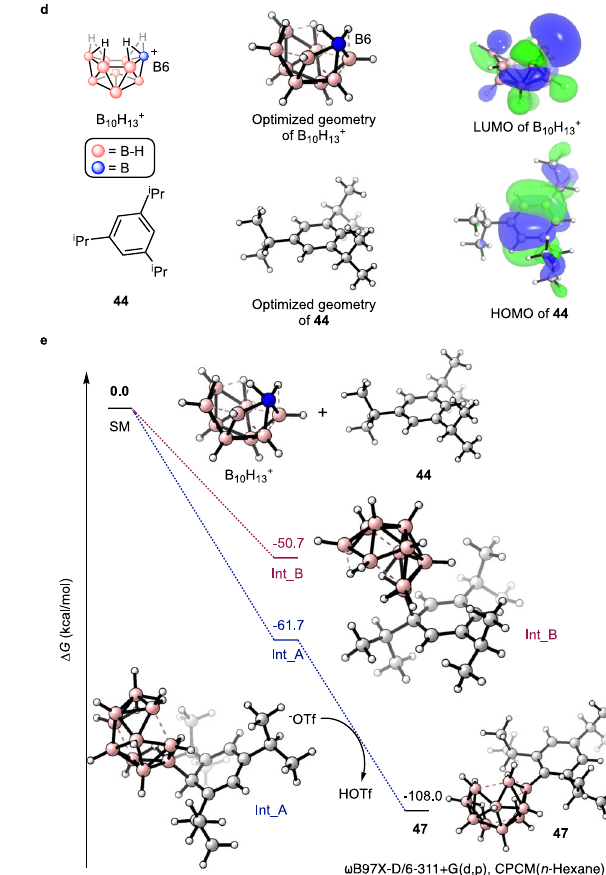
e DFT-calculated reaction pro fi le for the formation of 47 from B 10 H 13 + and 44 . All DFT calculations were conducted at the ⍵ B97X-D/6-311+G(d,p), CPCM( n -hexane) level of